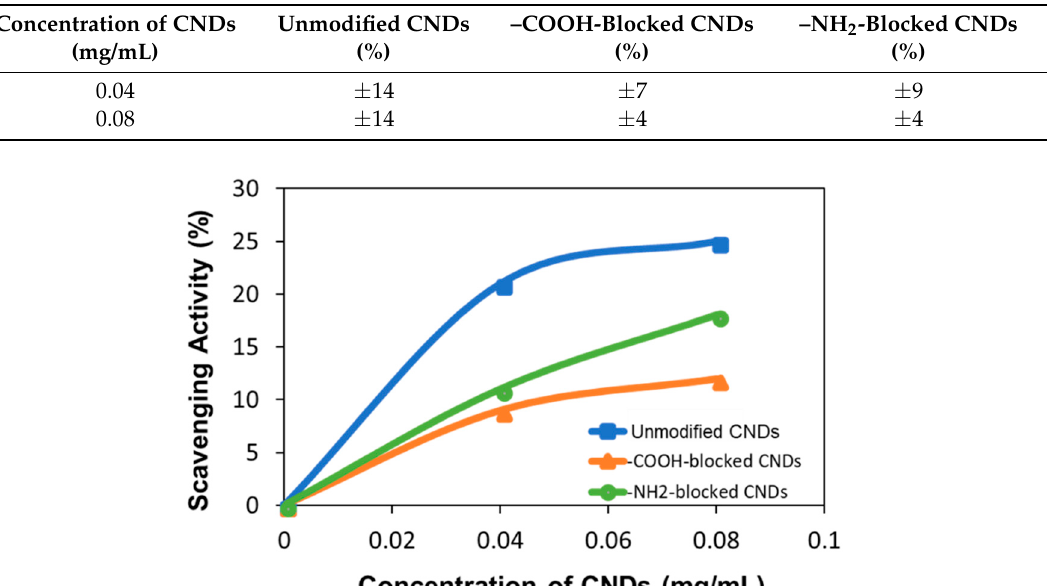
Table 1. The standard deviations of the averaged DPPH• scavenging activity of the three types of CNDs with different concentrations.